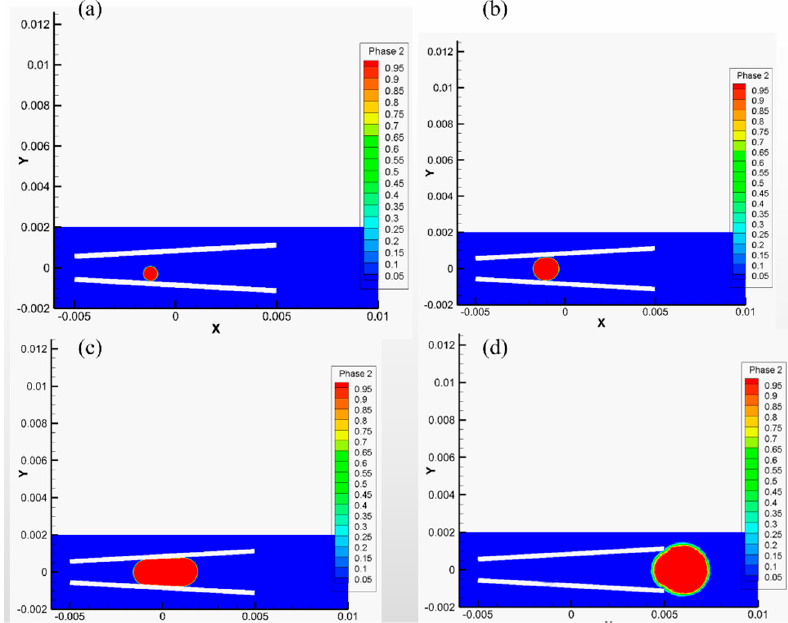
Figure 11. A phase diagram of bubbles in the stage of ( a ) bubble nucleation ( b ) bubble growth ( c ) bubble slip ( d ) bubble ejection, where red represents the gas and blue represents the fluid. Table 1. The driving forces, average speed, and duration of the bubble-driven micromotor at different stages.